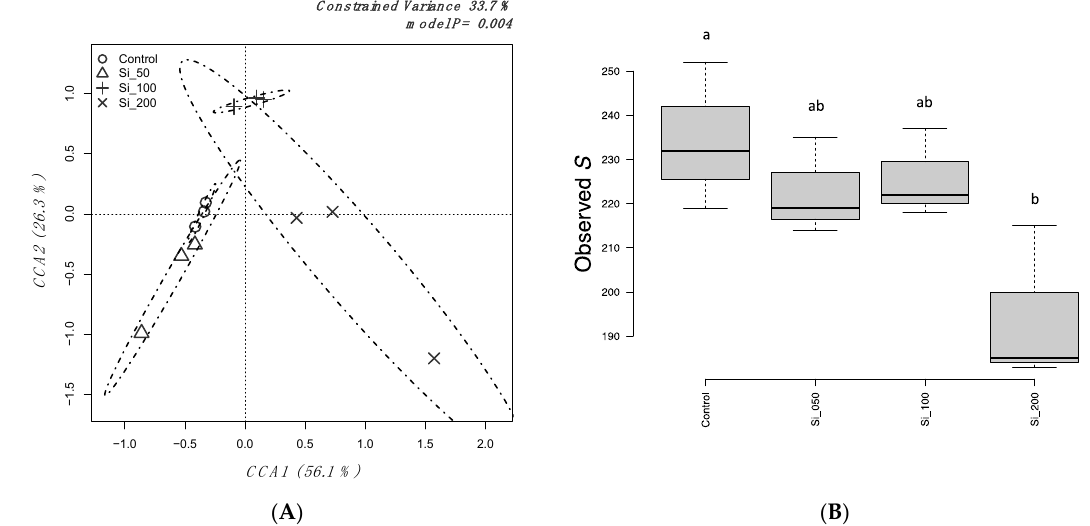
Figure 2. Principal component analyses of post-harvest quality data. ( A ) Canonical Correspondence Analysis (CCA) on the impact of Si biofortification on the relative abundances of all bacterial OTUs. ( B ) α-diversity index calculated as total number of observed OTUs (S). Treatments with the same letter are not significantly different according to Tukey’s test.